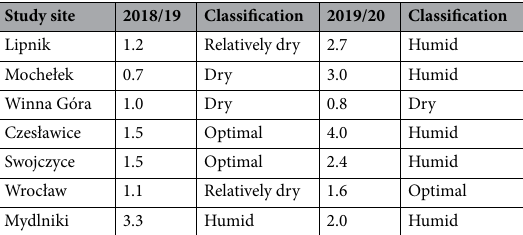
Table 9. Hydrothermal coefficient ( K ) calculated for the seasons 2018/19 and 2019/20 for the study